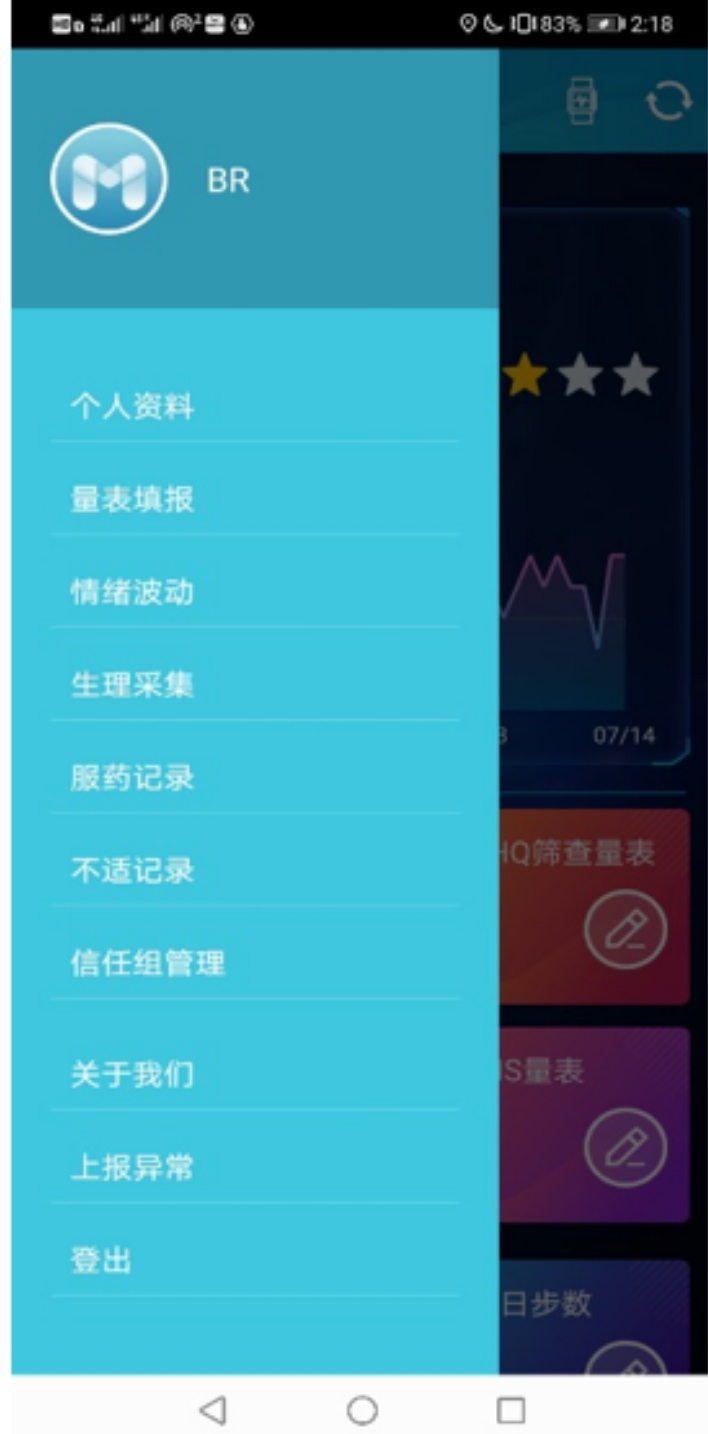
Figure 2. Screenshot of the menu